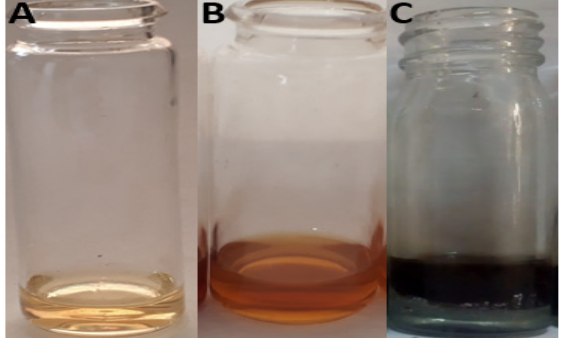
Figure 3. ( A ) Leaf extract + AgNO 3 solution before reaction, ( B ) Leaf extract + AgNO 3 solution after 1 h, and ( C ) Leaf extract + AgNO 3 after 24